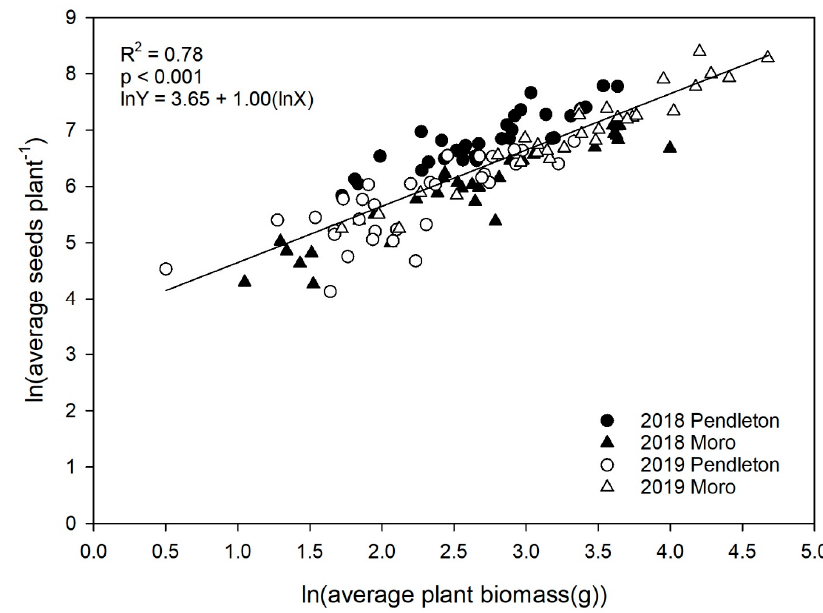
Figure 2. Relationship between average Russian thistle plant biomass (g) and Russian thistle seed production (seeds plant − 1 ) across sites and years. Solid line represents the average across sites and years. and